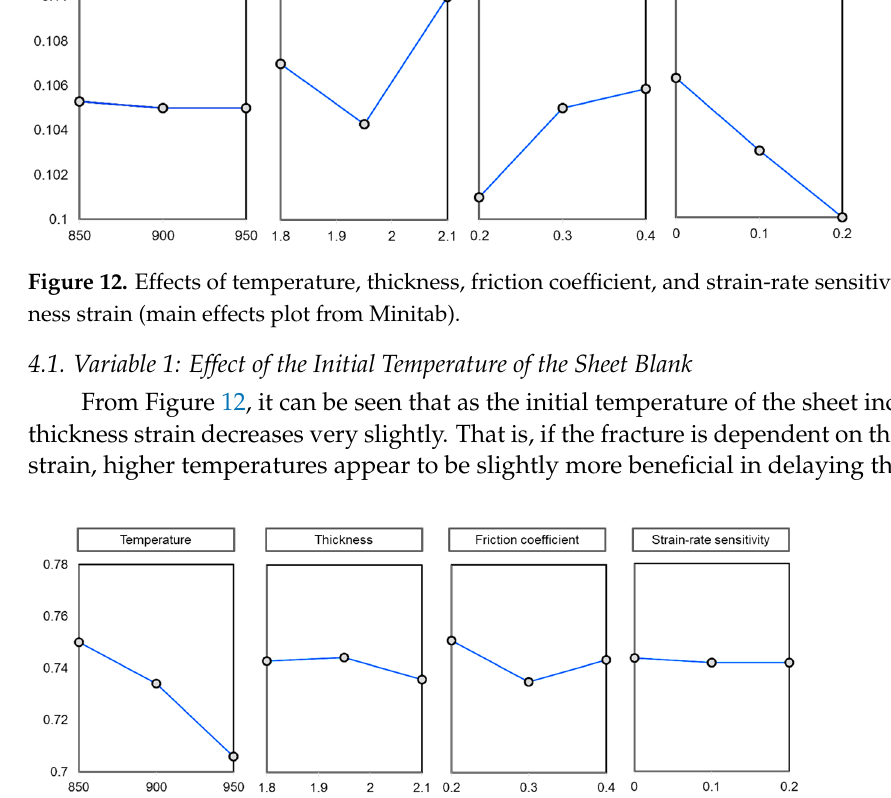
Figure 13. Effects of temperature, thickness, friction coefficient, and strain ‐ rate sensitivity on mar ‐ tensite phase ratio (main effects plot from Minitab).